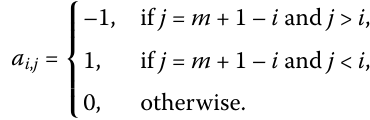
Table 1 Comparison between the Algorithm A and Algorithm 3.5 in [23] x 0 Algorithm A Algorithm3.5in[23]